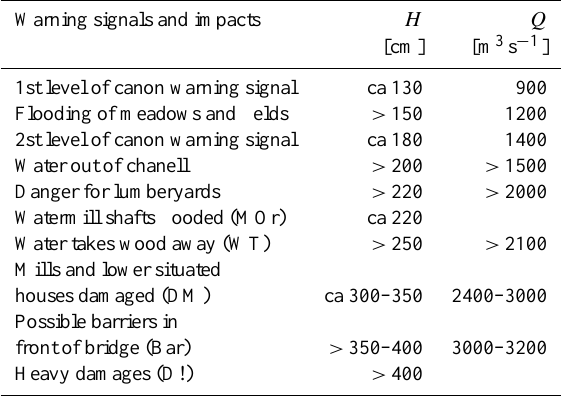
Table 3. Selected important impacts with relations between water levels and peak